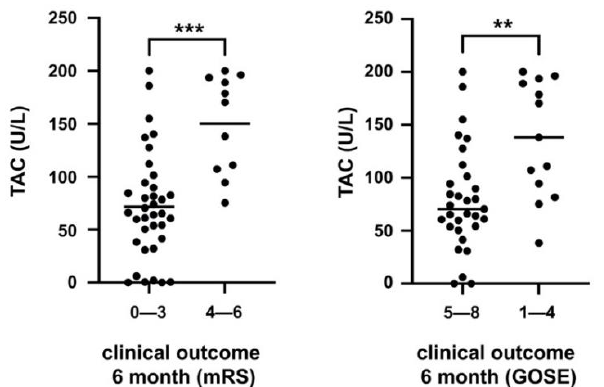
Figure 4. Unfavorable outcome 6 months after SAH is associated with increased plasma TAC levels (mRS: modified Rankin Scale, p = 0.0001; GOSE: Glasgow Outcome Scale Extended, p = 0.001). **: p < 0.01; ***: p < 0.001.